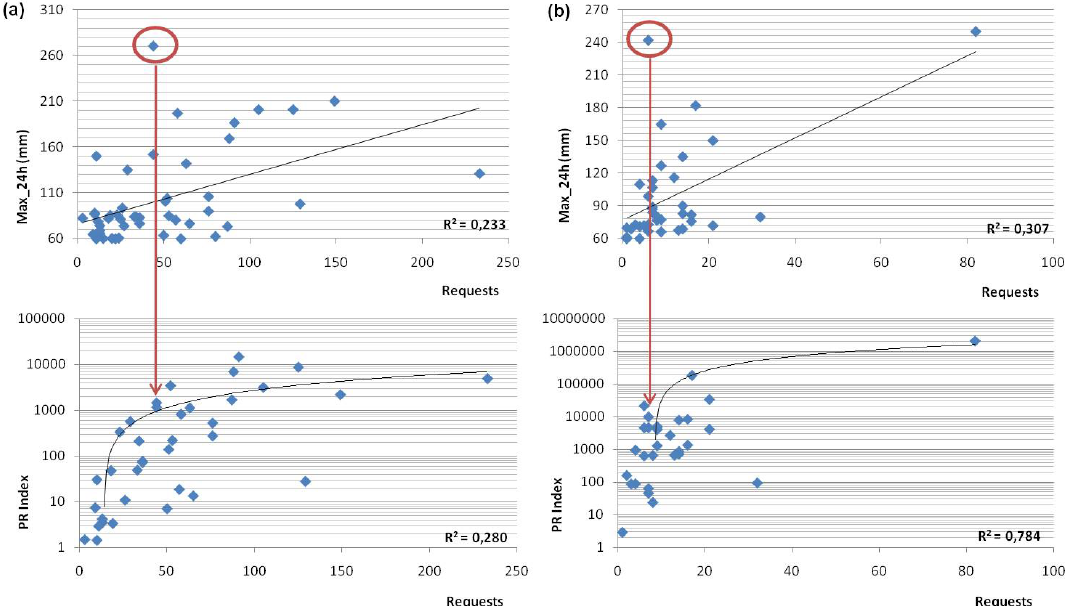
Fig. 7. Interrelation between the number of requests and the maximum rainfall in 24h recorded during each SIR event (up) and with the index PR built (down), for: (a) Catalonia and (b) the Balearic Islands.